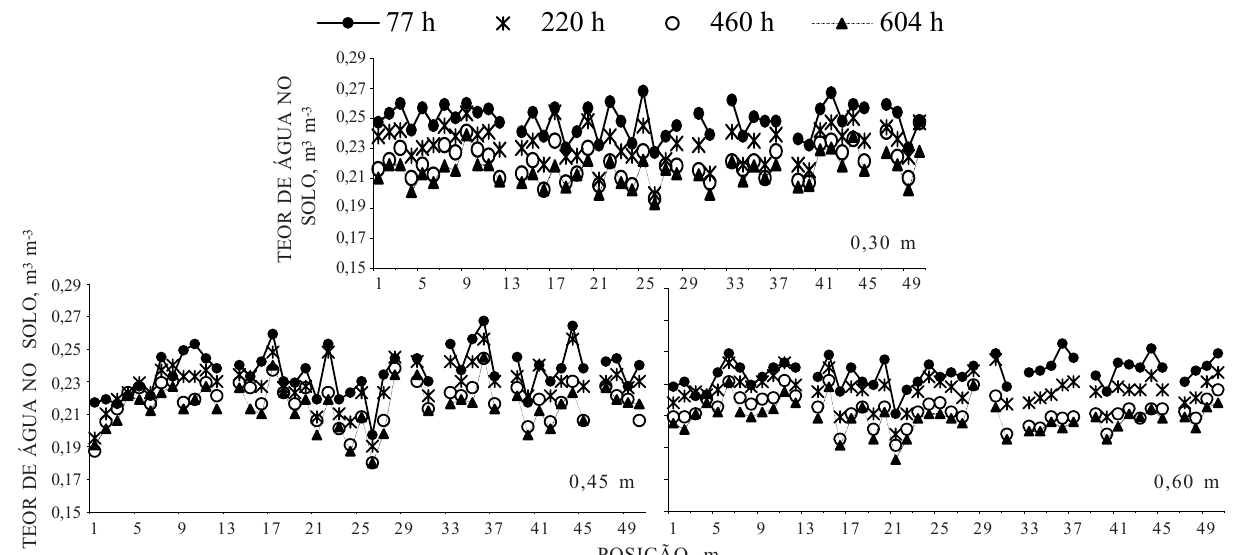
Figura 2. Variabilidade do teor de água no solo, segundo uma transeção de 50 pontos espaçados de um metro, em três profundidades e quatro tempos de amostragem. A linha interrompida indica os cinco pontos de medida que foram